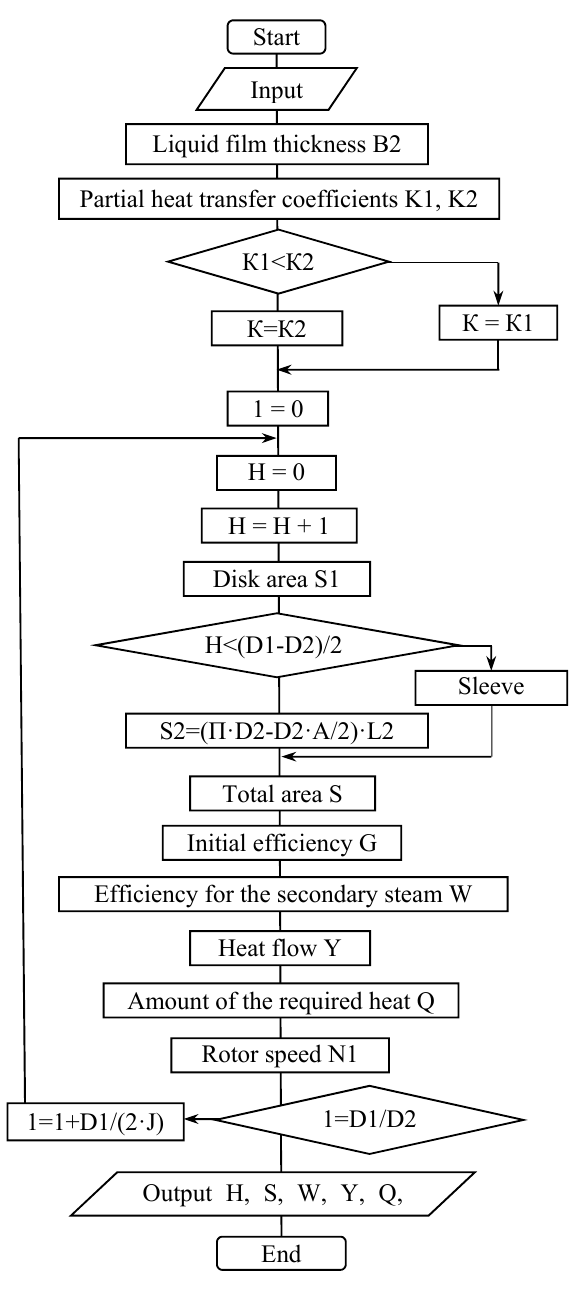
Fig. 2. Calculation